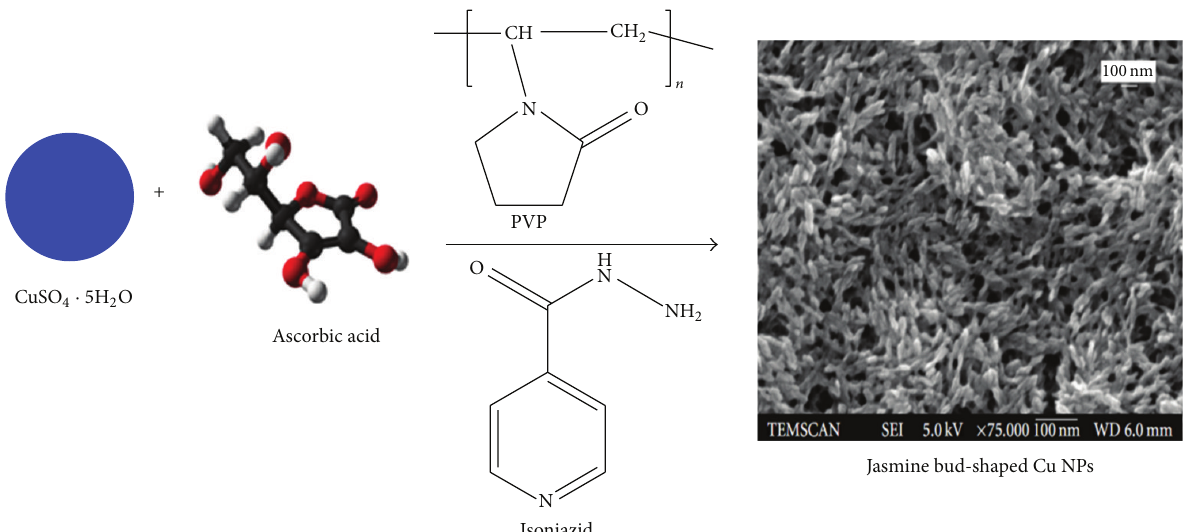
Scheme 1: Schematic illustration of synthesis of jasmine bud shaped copper nanoparticles. Copper sulfate reacts with PVP to form a complex which is reduced by ascorbic acid and isoniazid resulting in copper